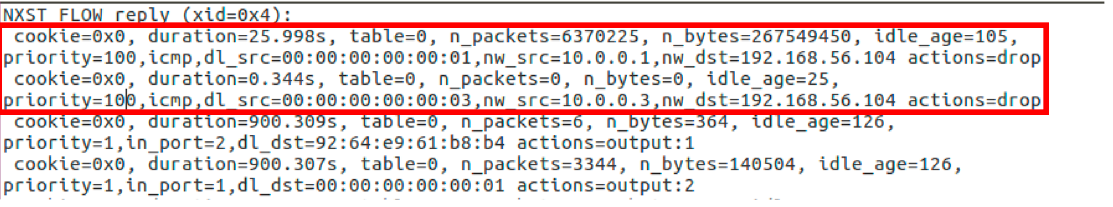
Figure 10. Scenario I—OpenFlow Switch’s Flow Table after DDoS Attack.